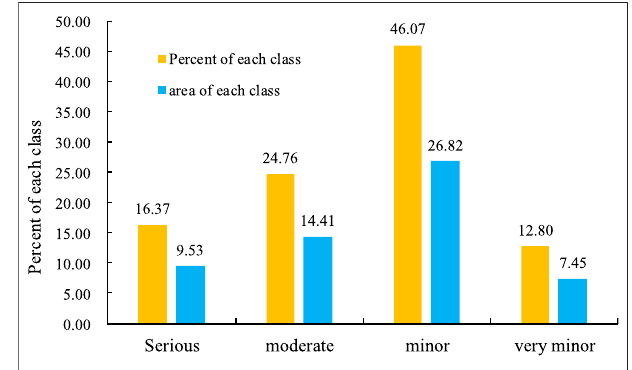
FIGURE 9 | Percentage of each class of the degree of surface damage.